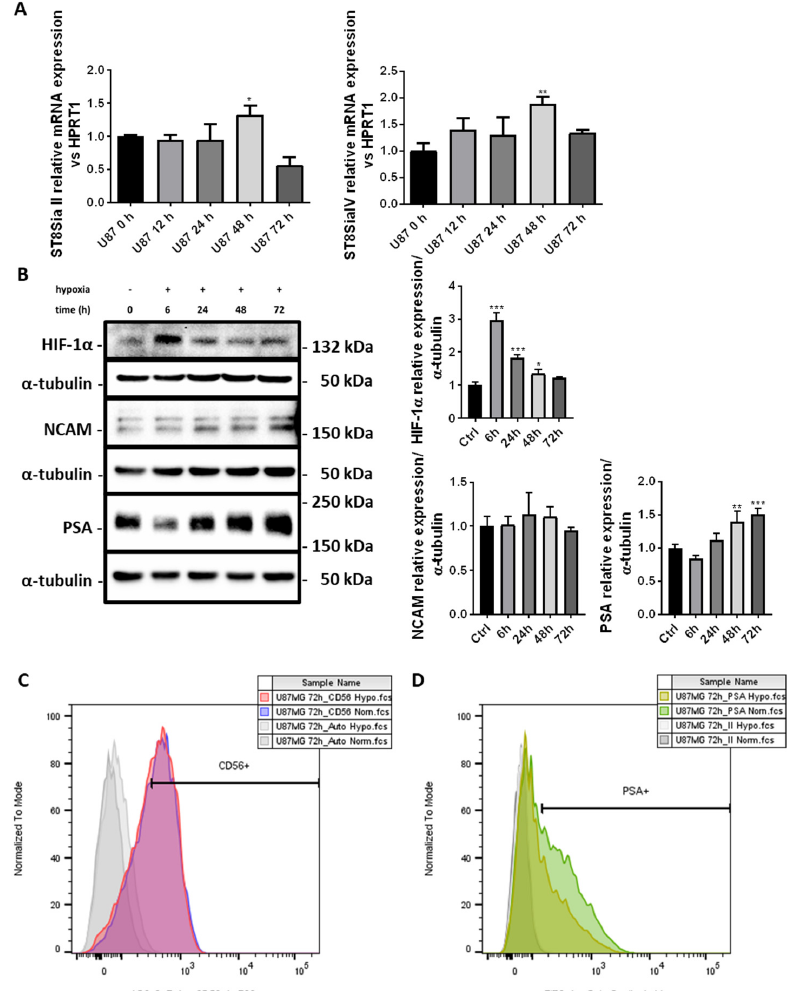
Figure 2. PolySTs, NCAM and PSA expression in U87-MG cells under chronic hypoxia. ( A ) Real-Time PCR analysis showing the time-course (0–72 h) of mRNA expression of polysialyltransferases II and IV (ST8SiaII and ST8SiaI(V) in U87-MG cells exposed to low oxygen concentrations. ( B ) Western blot analysis showing the time-course (0–72 h) of HIF-1 α activation, NCAM and PSA expression in U87-MG cells under hypoxia. ( C ) Cytofluorimetric analysis showing the extracellular expression of NCAM (CD56) in U87-MG cells exposed for 72 h either to chronic hypoxia (red histogram) or normoxia (blue histogram). ( D ) Cytofluorimetric analysis showing the extracellular expression of PSA in U87-MG cells exposed for 72 h either to chronic hypoxia (light green histogram) or normoxia (green histogram). All results are expressed as the mean ± SD of three independent